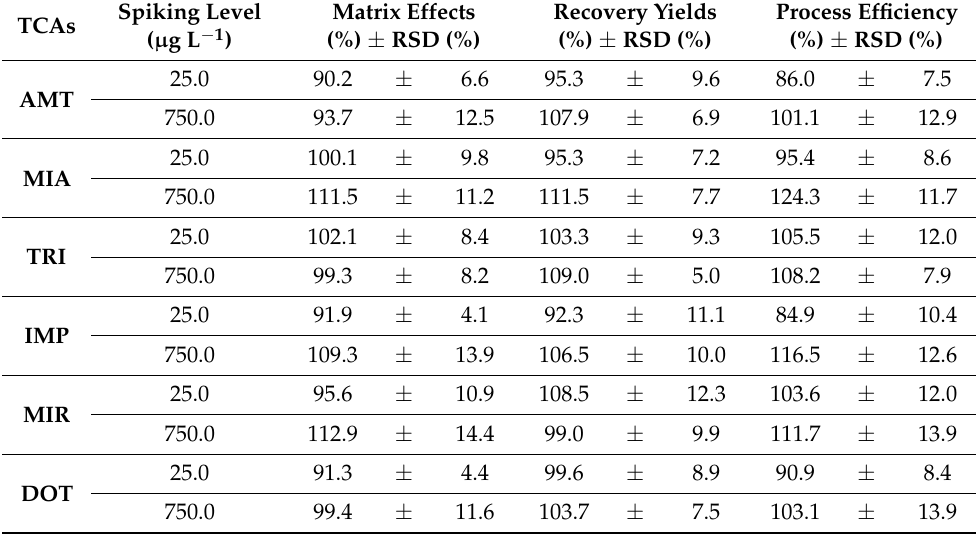
Table 4. Matrix effects, recovery yields and process efficiency obtained for the six TCAs at two imental